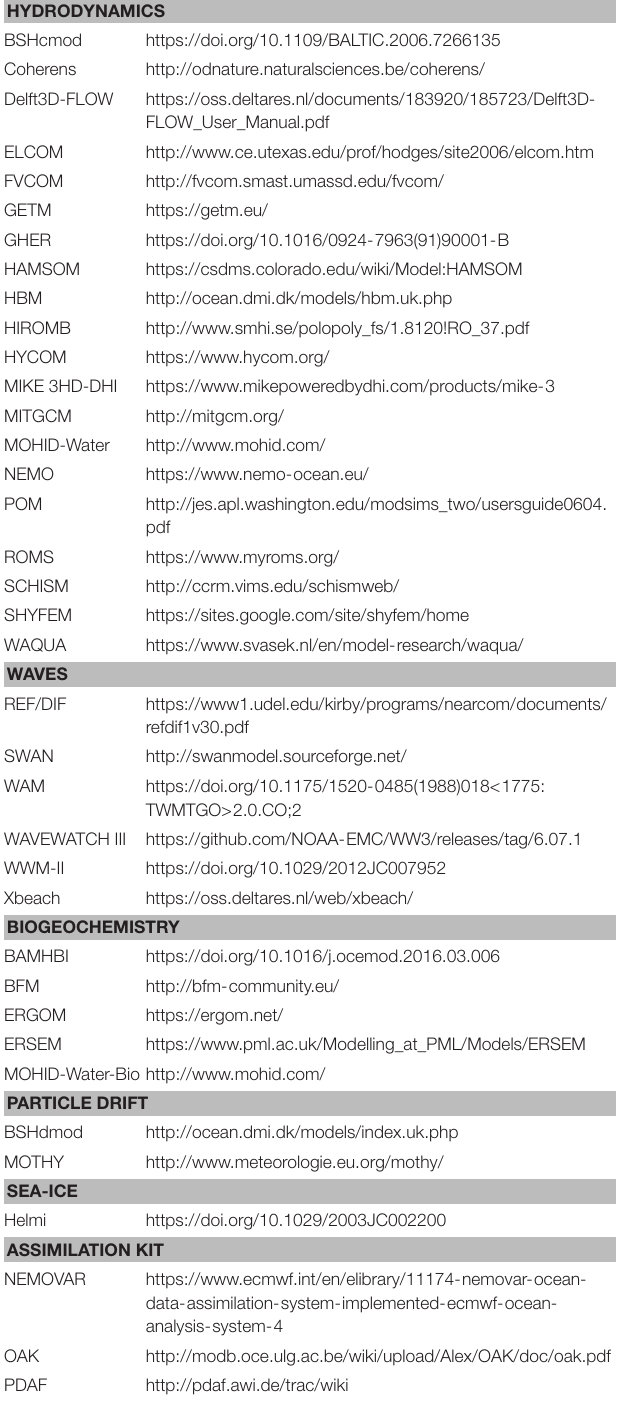
TABLE 2 | List of the model softwares involved in the present survey, and documentations. HYDRODYNAMICS